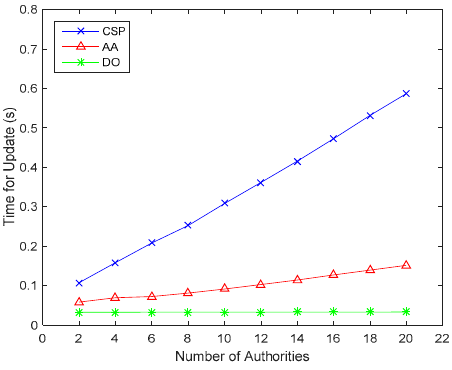
Figure 6. Comparison of computing cost of CSP, AA and DO in the attribute revocation process.